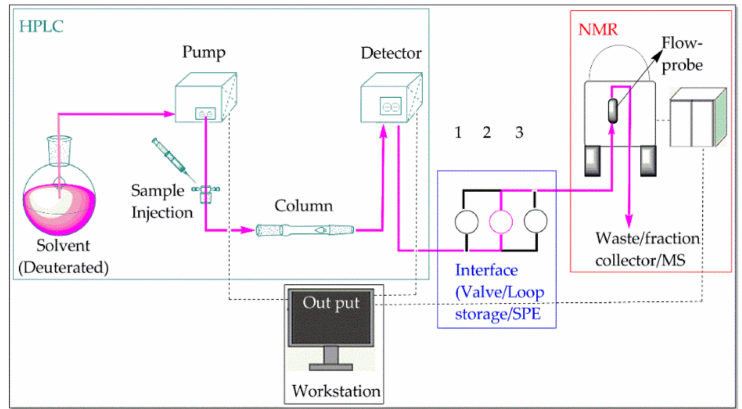
Figure 1. The instrumental setup of LC–NMR